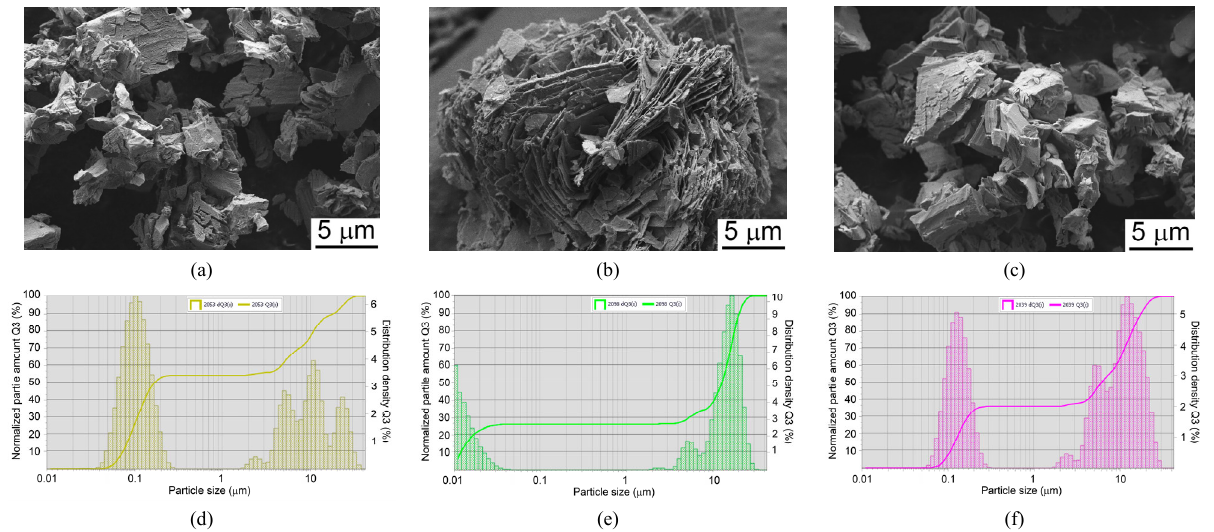
Fig. 1 SEM (a–c) and particle size distribution obtained by DLS method (d–f) of Alpha-Micro (a, d), Alpha-Nano (b, e), and ITO-V (c, f) commercial Y 2 O 3